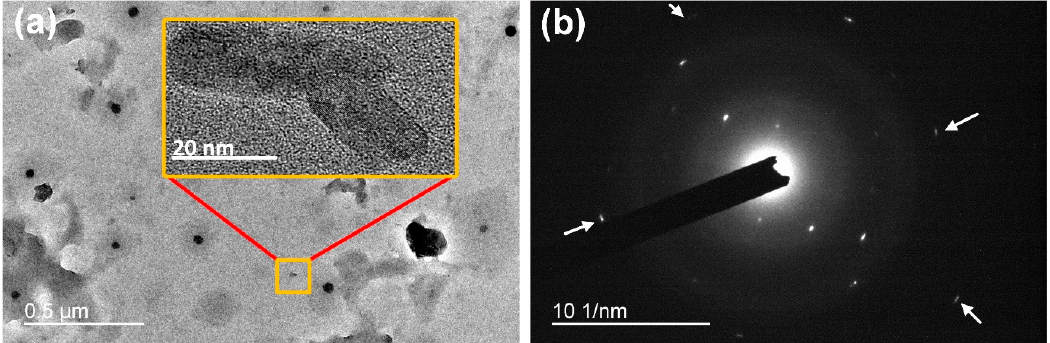
Figure 7. ( a ) Local view of β -sheet crystals in PU/RSF (75/25) composite fibres crystal size ranging from 50 to 450 nm. ( b ) Diffraction pattern obtained from randomly chosen β -sheet crystal in transverse section of fibres PU/RSF (75/25) blended fibres. The patterns show the anisotropic arrangement of the polycrystalline β -sheets. d spacing value of RSF crystals: silk I (Å), 4.4, 4.1, 3.6, and 2.8 Å; silk II (Å), 4.8 and 4.3 Å.